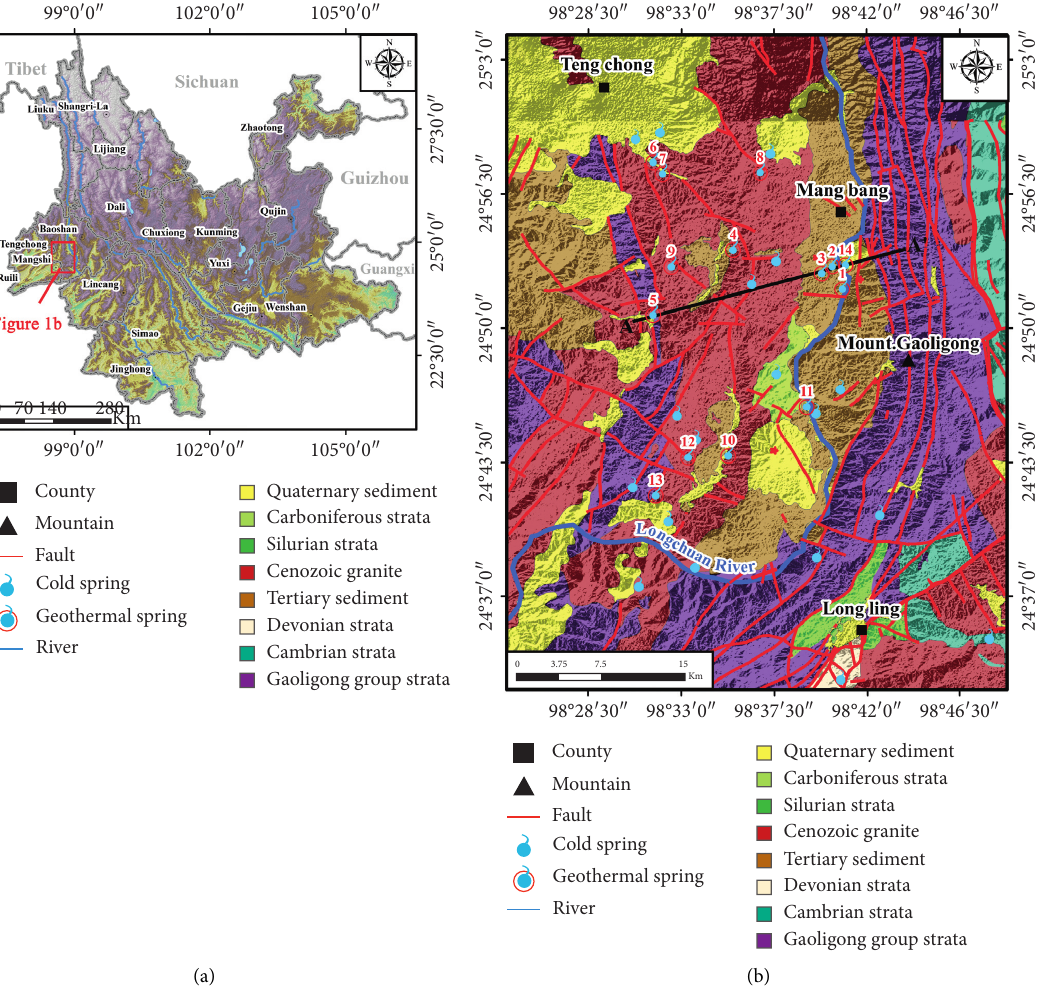
Figure 1: Geological map of the Mangbang-Longling area in western Yunnan within the distribution of geothermal waters.